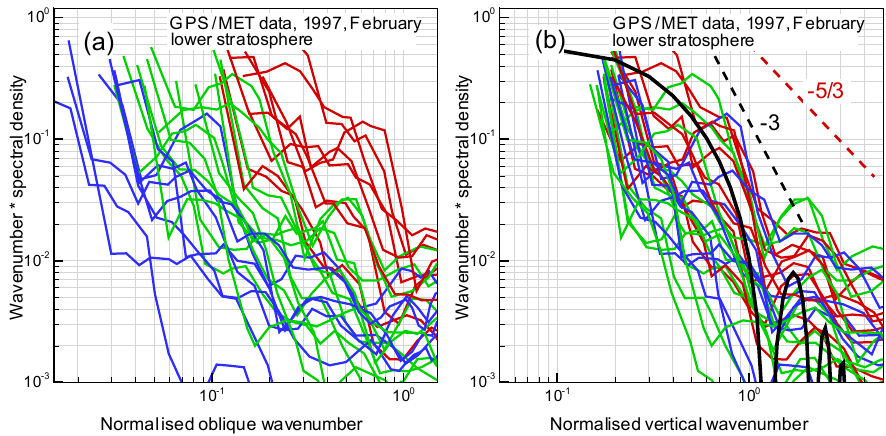
Figure 4. The normalized eikonal fluctuation spectra for the lower stratosphere: (a) spectra as functions of the oblique wave number cor- responding to the isotropy hypothesis; (b) spectra as functions of the vertical wave number corresponding to the anisotropy hypothesis. The black solid line in panel (b) represents the theoretical vertical spectrum for the saturated IGW model; the dashed line represents its asymptotics. For the comparison, red dashed lines show the high-frequency spectral asymptotic of the Kolmogorov turbulence model; cf. the caption of Fig. 2.